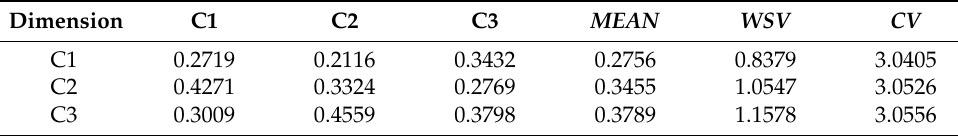
Table 8. The normalized comparison matrix of